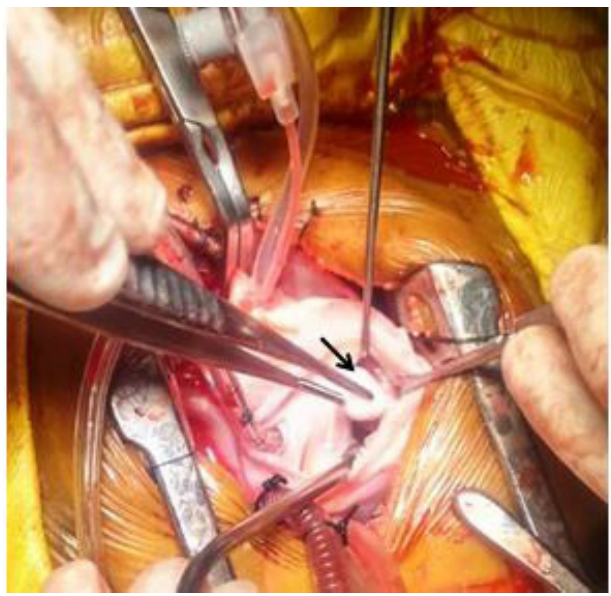
Fig. 2 – Intraoperative findings showing a pedunculated mass from right ventricular outflow